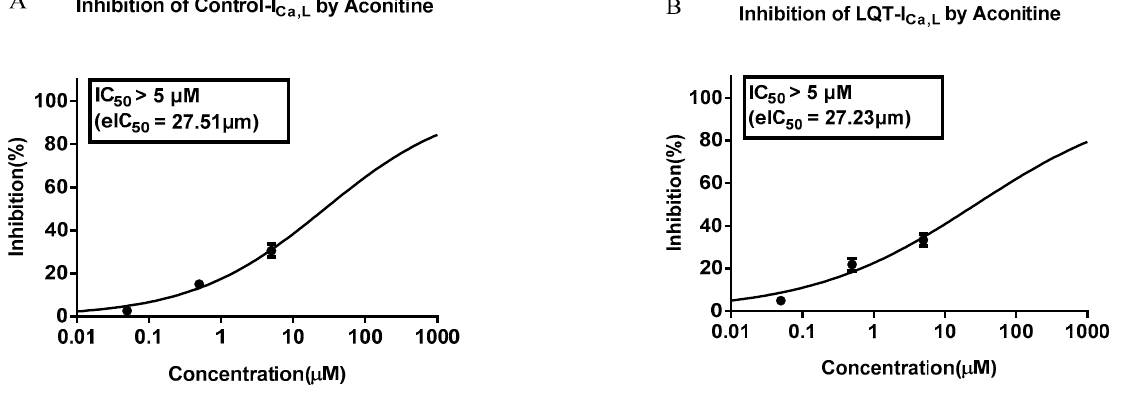
Figure 8. Effects of AC on calcium transients in normal and LQT syndrome hiPSC-CMs. ( A ) normal